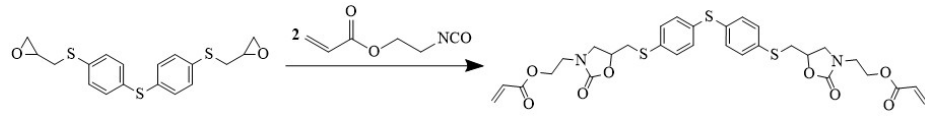
Figure 4. Synthesis of AOI-UV photopolymer.